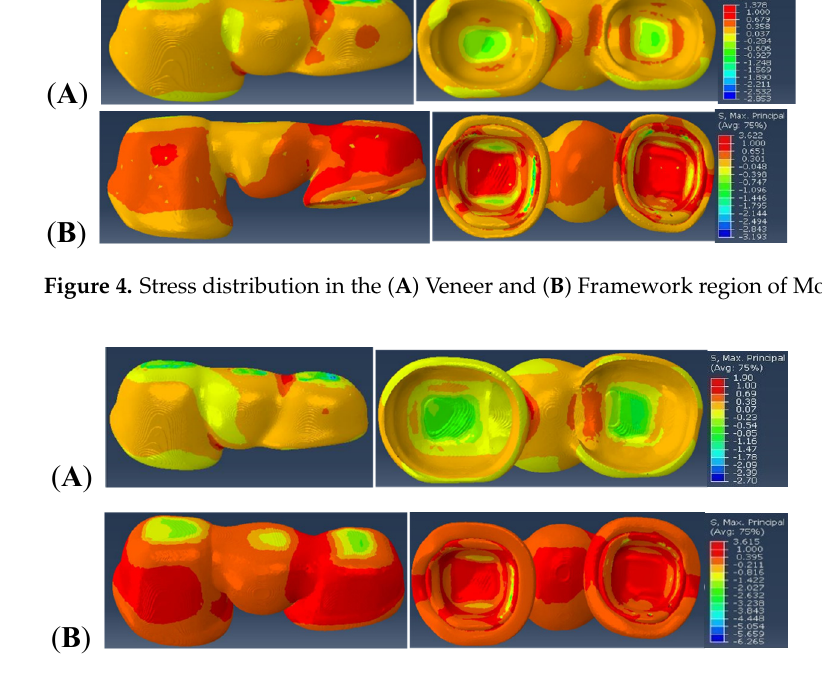
Figure 5. Stress distribution in the ( A ) Veneer and ( B ) Framework region of Model